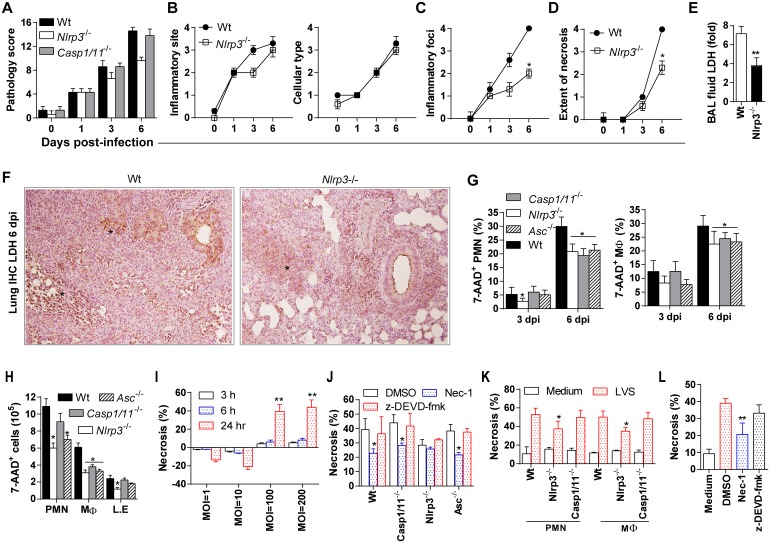
Tissue pathology and necrotic death of myeloid cells is reduced in Ft infected Nlrp3-/- mice.(A) Lung pathology score for mice infected with lethal Ft LVS (1000 cfu). Pathology score was calculated by analysis of lung sections (n = 6 mice) for location/type/and extent of inflammation and necrosis (see Methods) (mean ± SD of two experiments, Mann-Whitney test, *p<0.05 indicates difference from wildtype mice). (B) Individualized pathology scores for inflammatory site and cellular types (mean ± SD of two experiments as shown in panel A). (C-D) Individualized pathology scores for number/size of inflammatory foci and extent of necrosis (mean ± SD of two experiments, n = 6 mice, Mann-Whitney test, *p<0.05). (E) LDH level in BAL fluid following LVS-infection (mean ± SD of two independent experiments, Student’s t-test, **p<0.01). (F) Positive immunoreaction for localization of LDH (asterisk), as an indicator of necrosis, in representative lung section at 6 dpi (IHC with hematoxylin counterstaining, 400x). (G) Per cent 7-AAD+ neutrophils (PMN) and macrophages (MØ) in Ft-infected lungs at 3 and 6 dpi (mean ± SD of two independent experiments, Student’s t-test, *p<0.05 indictaes difference from wildtype mice). (H) Total number of 7-AAD+ cells in Ft-infected lungs at 6 dpi (mean ± SD of two independent experiments, Student’s t-test, *p<0.05). (I) Per cent necrotic cells calculated by LDH release in BMDM infected with Ft LVS at increased MOI for different time points (mean ± SD of three independent experiments, Student’s t-test, **p<0.01 indicates difference from 3 and 6 h at specified MOI). (J) Per cent necrosis (LDH release) of BMDM pre-treated (30 min) with z-DEVD-fmk (50 μM) or Nec-1 (50 μM) and then infected with Ft LVS (MOI = 100) for 24 h (mean ± SD of three independent experiments, Student’s t-test, *p<0.05 indicates difference from LVS-infected cells treated with DMSO). (K) Per cent necrosis (LDH release) of PMN or lung macrophages infected with Ft LVS (MOI = 100) for 24 h (mean ± SD of two independent experiments, Student’s t-test, *p<0.05 indicates difference from wildtype cells). (L) Per cent necrosis (LDH release) of LA-4 cells infected with Ft LVS (MOI = 100) for 24 h (mean ± SD of three independent experiments, Student’s t-test, *p<0.05 indicates difference from LVS-infected cells treated with DMSO).